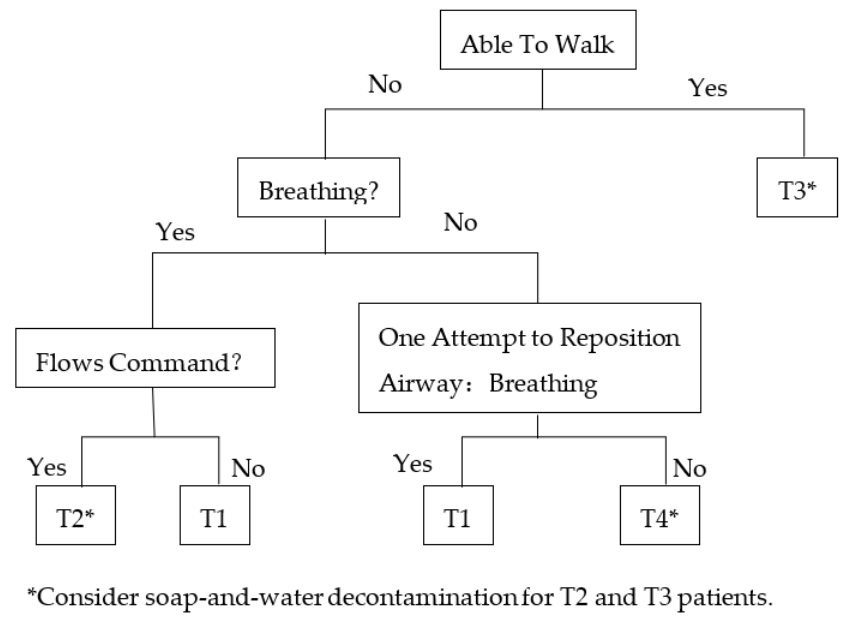
Figure 3. Triage algorithm based on START and the GCS.